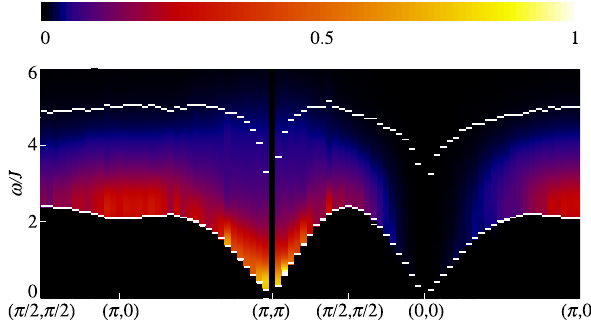
FIG. 5. The dynamic structure factor of the 2D Heisenberg model computed on an L ¼ 48 lattice along a standard path in the BZ indicated on the x axis. The y axis is the energy transfer ω in units of the coupling J . The magnon peak ( δ function) at the lower edge of the spectrum is marked in white irrespective of its weight, while the continuum is shown with color coding on an arbitrary scale where the highest value is 1. The upper white curve corresponds to the location where, for given q , 5% of the spectral weight remains above it.